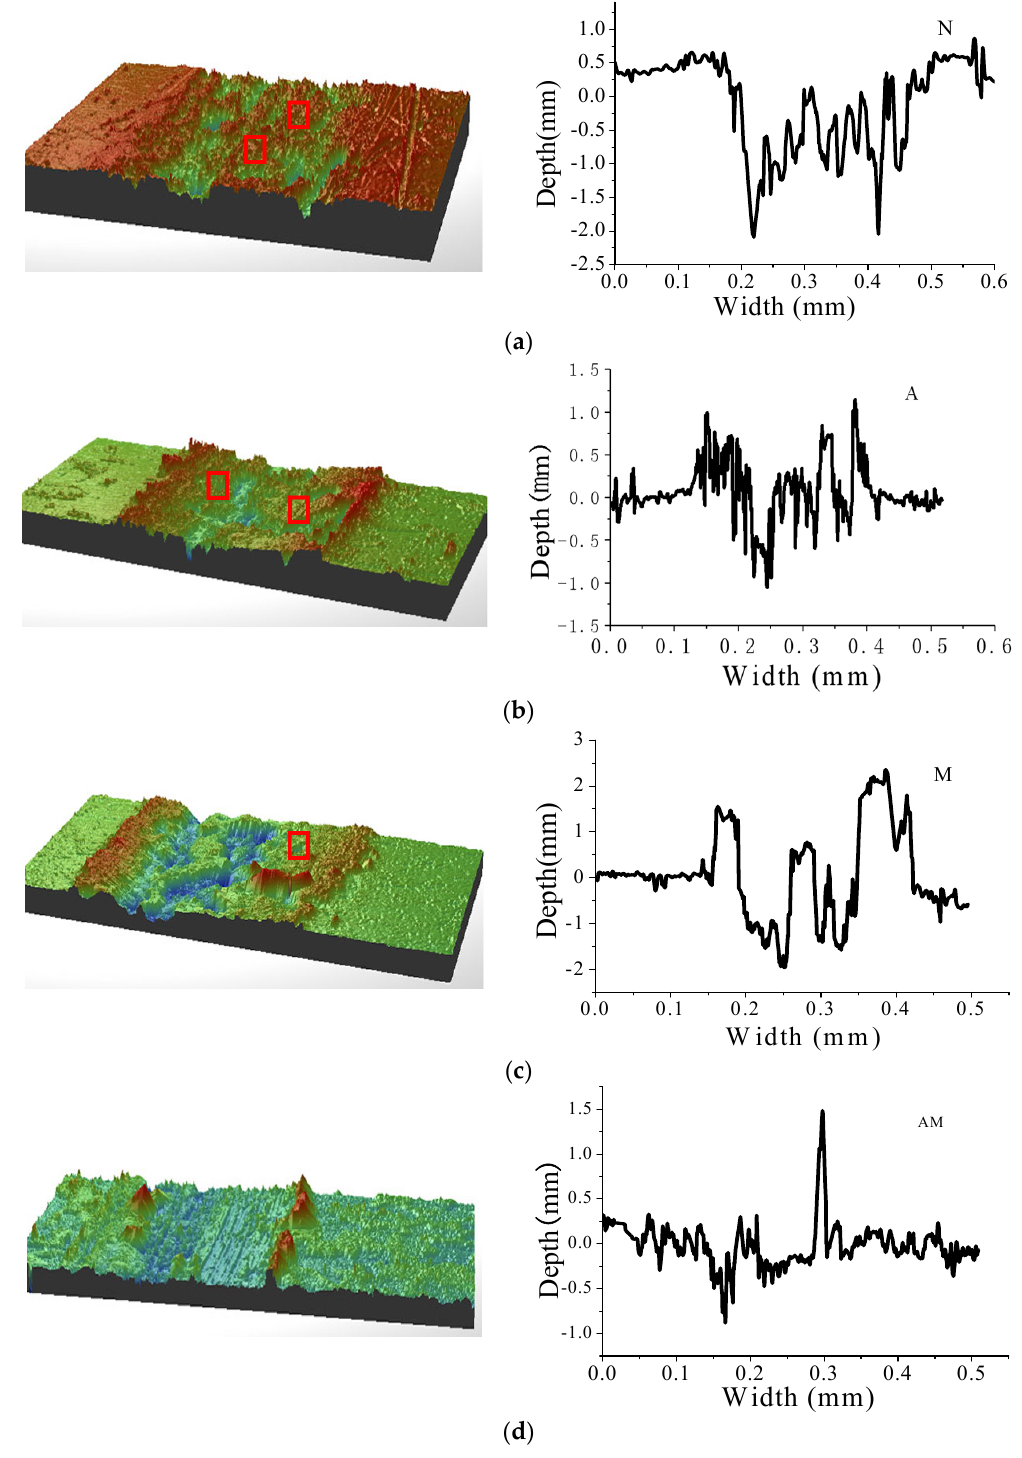
Figure 6. The cross ‐ section profiles, surface 3D topographies of wear tracks for ( a ) N, ( b ) A, ( c ) M, and ( d ) AM after the wear test.